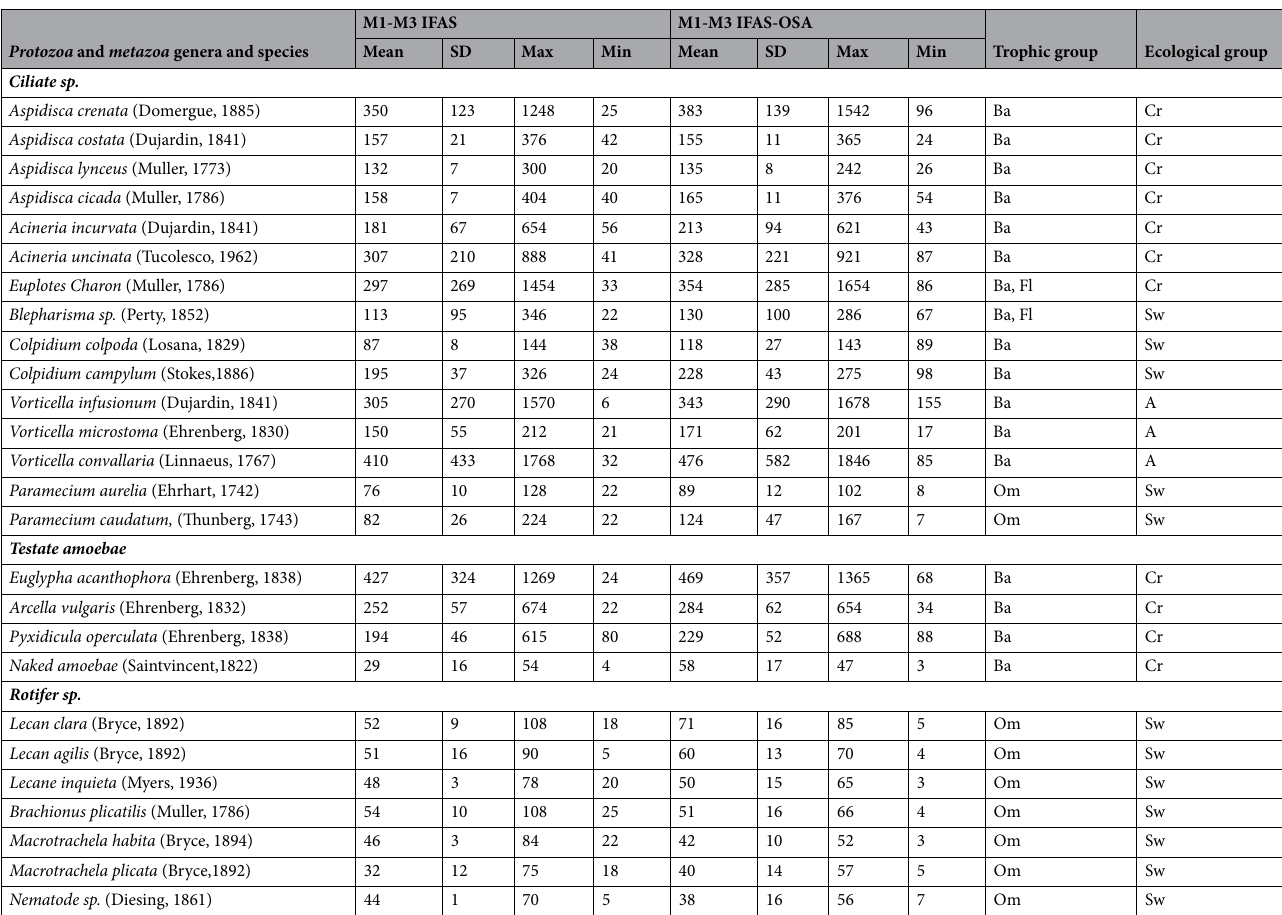
Table 8. Distribution of the protozoa and metazoa genera and species (Indiv/Cm 3 ) in the IFAS and IFAS- OSA systems. Trophic groups: Ba-bacterivorous; F-consumer of heterotrophic flagellates; Om – omnivorous; Ecological groups: A- attached; Cr- crawling; Sw- free swimming; M1: First month (April); M2: Second month (May); M3: Third month (June), Indiv: Individual. **Mean, Min, and Max: the average, minimum, and maximum (Indiv/Cm 3 ) of the protozoa and metazoa genera and species from different sites of the IFAS and the IFAS-OAS